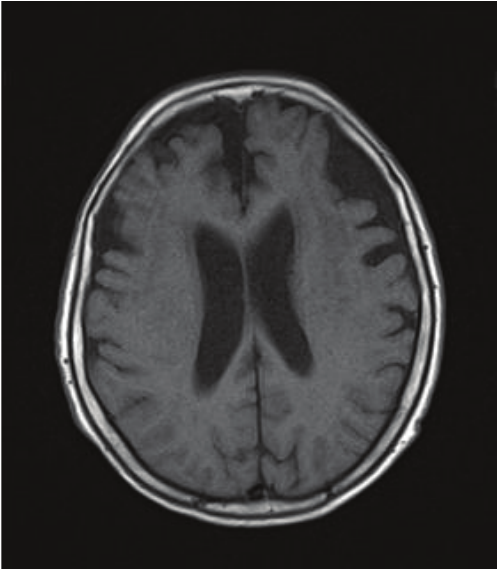
Figure 1: Magnetic resonance image on hospital day 10 shows moderate cortical atrophy especially in the frontal